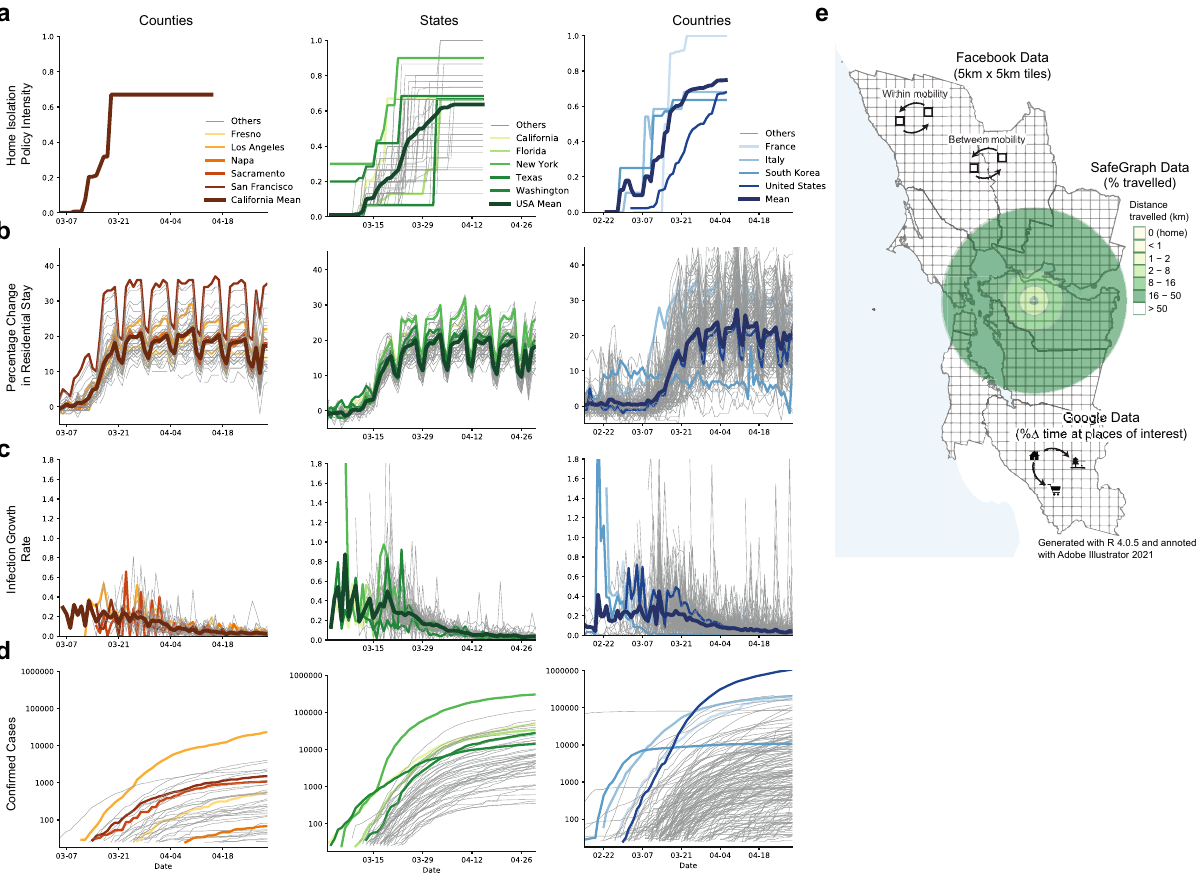
Figure 1. Data on mobility measures, COVID-19 infections and home isolation policy adoption. ( a ) Home isolation policy adoption, ( b ) Change in time spent at home, ( c ) Infection growth rate, and ( d ) Total confirmed cases are displayed at the county, state and country level. ( e ) Illustrative example of different mobility measures in California. We utilize data on trips both within and between counties (Facebook and Baidu) as well as the purpose of the trip (Google) and the average distance traveled